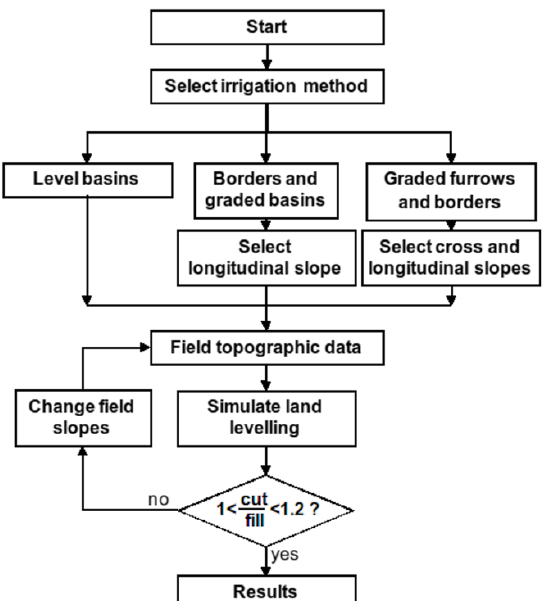
Figure 2. Flowchart of the application of the land leveling simulation